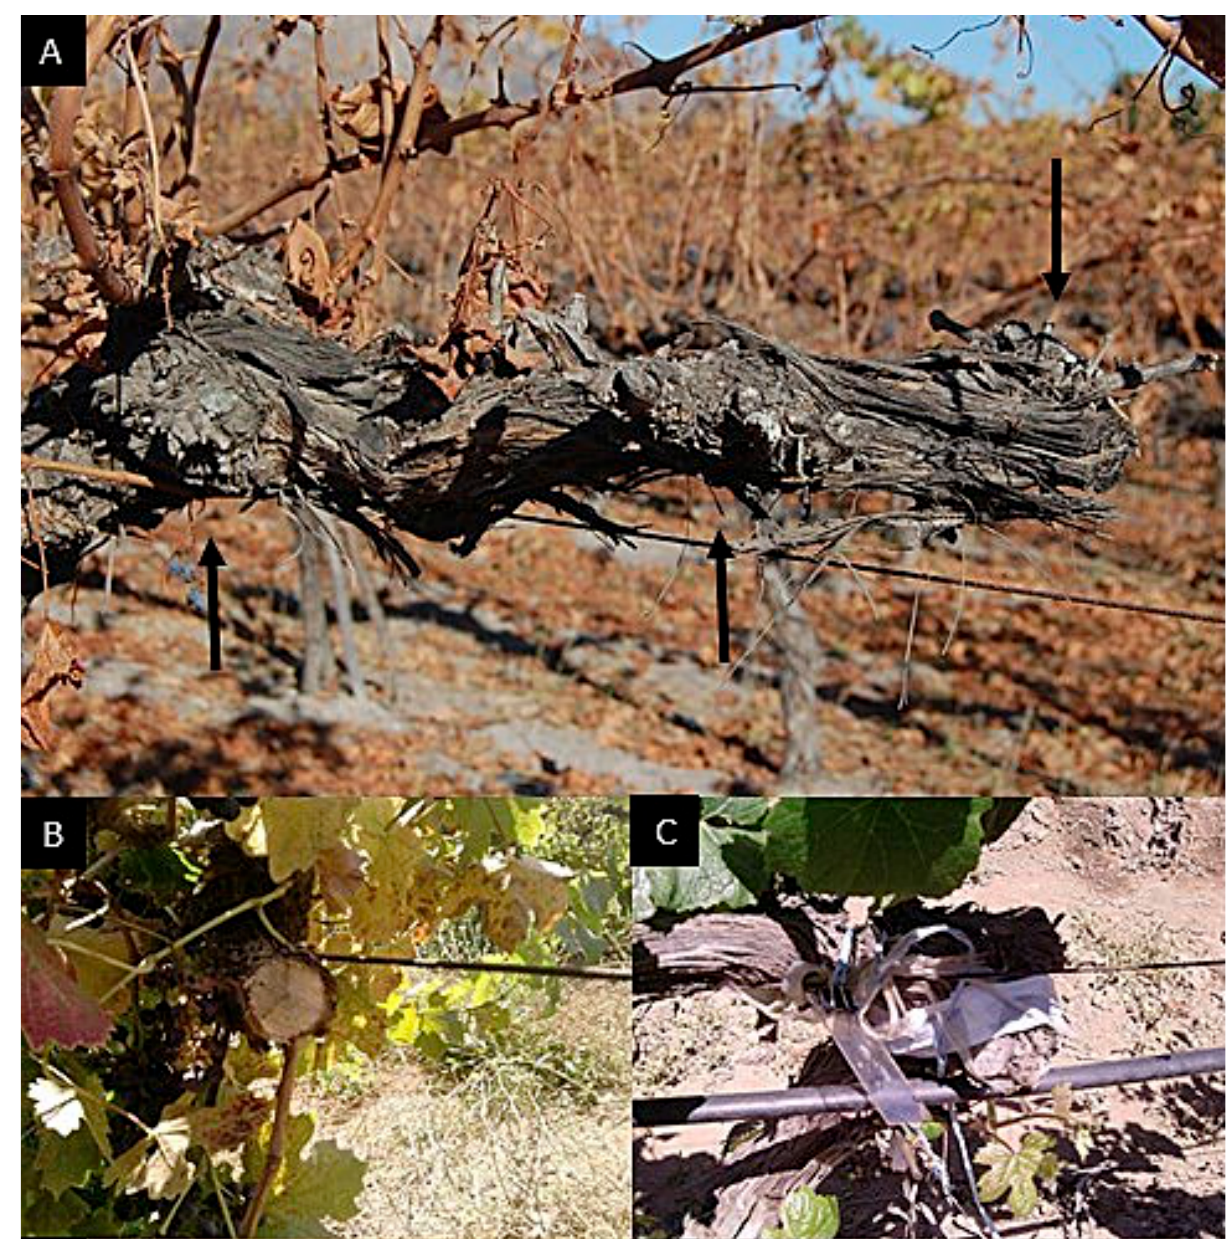
Figure 1. A. Symptoms of Botryosphaeria dieback in grapevine: black arrows indicate dead grayish-brown shoots. B. Trans- verse cut showing V-shaped necrosis in Cabernet Sauvignon in Panquehue. C. Spore trap placed on a Chardonnay cordon in